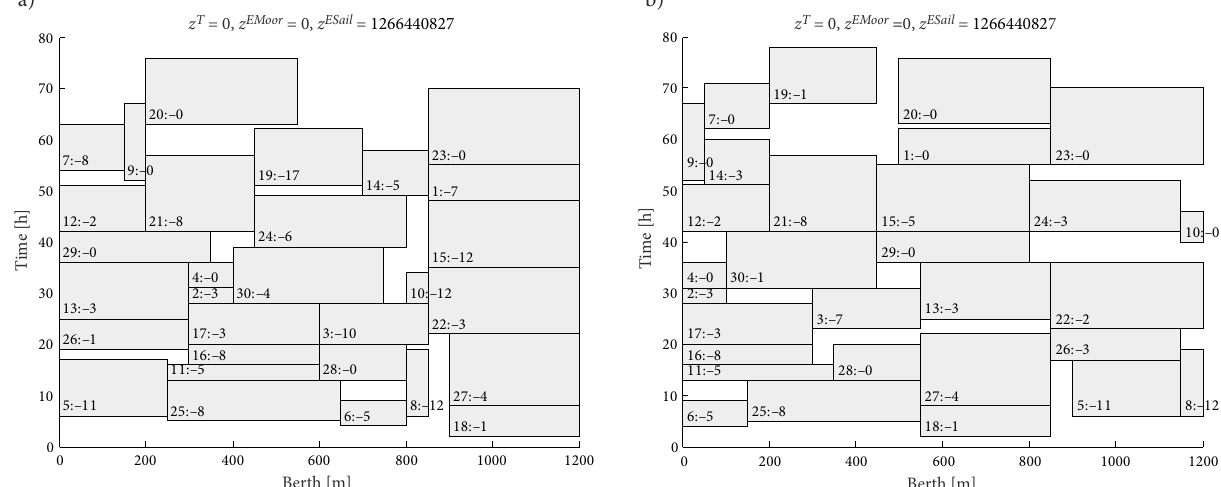
Figure 4. Minimizing emission and then weighted delay by two-stage method: a – minimizing sailing emission and then weighted delay; b – minimizing total emission and then weighted